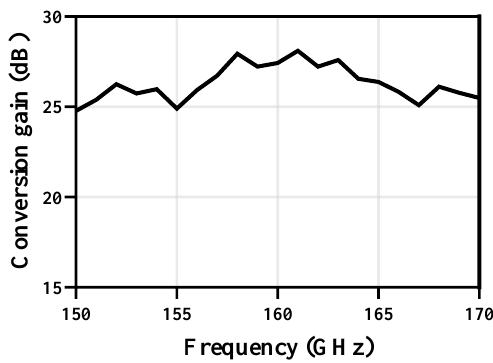
Conversion gain results at 1 GHz IF for the proposed receiver are shown in Figure 12. From 150 GHz to 170 GHz, the proposed receiver achieves an overall CG above 25 dB and a maximum CG of 28 dB was achieved at 158 GHz.